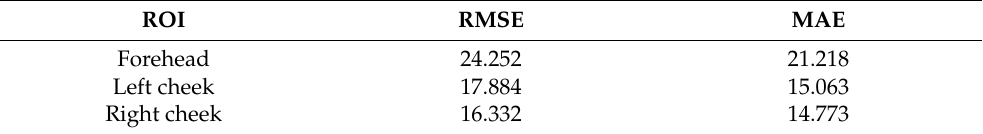
Table 2. Result of training EfficientNetB3 with 1 ROI as an input.